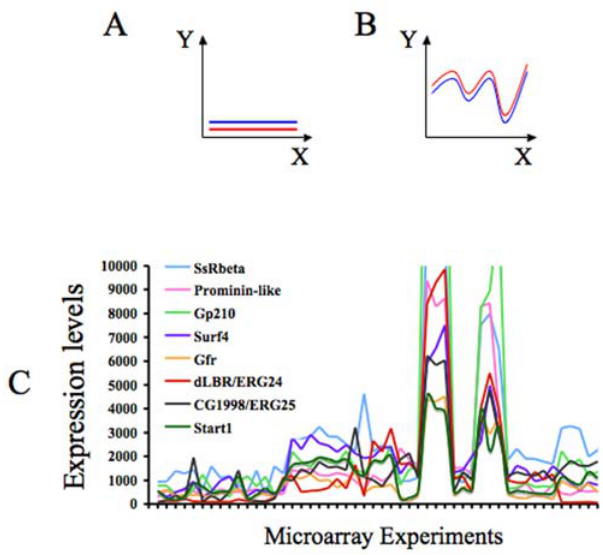
Figure 5. Expression profiles of several genes expressionally correlated with dLBR and CG1998. Panels A and B show schematic profiles displaying very strong R. However, in panel A ‘‘co-variation’’ is not very informative, in this case either the red and blue genes are not expressed or do not change their expression in the conditions analyzed. To avoid this artificial inflation of R, we have focused on experiments where the genes of interest display strong variation (as in panel B). Panel C: Expression profiles of several genes involved in protein trafficking and folding, which co-vary with the expression of dLBR and CG1998. The profile of Start1 is also